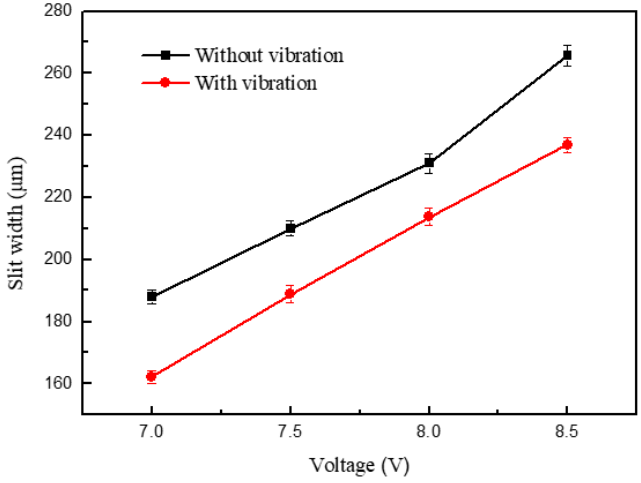
Figure 13. Variation in the slit width in relation to voltage.